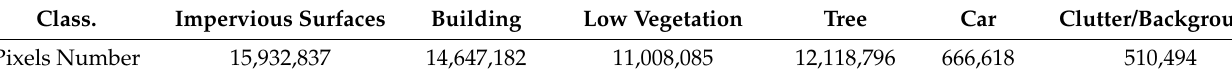
Table 1. The pixel number of each class in the training set.